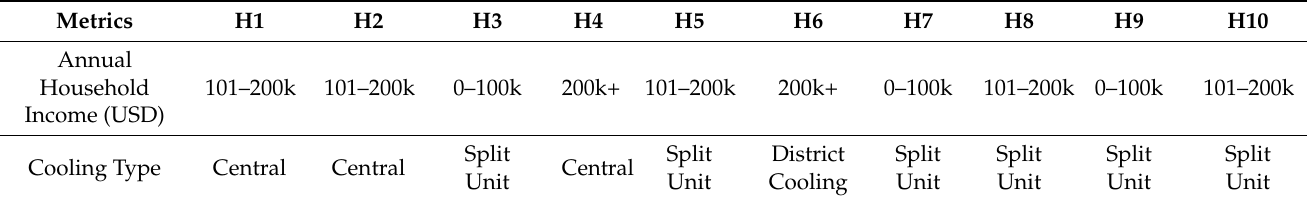
Table 2. Available roof space in comparison with photovoltaic (PV) system sizing.